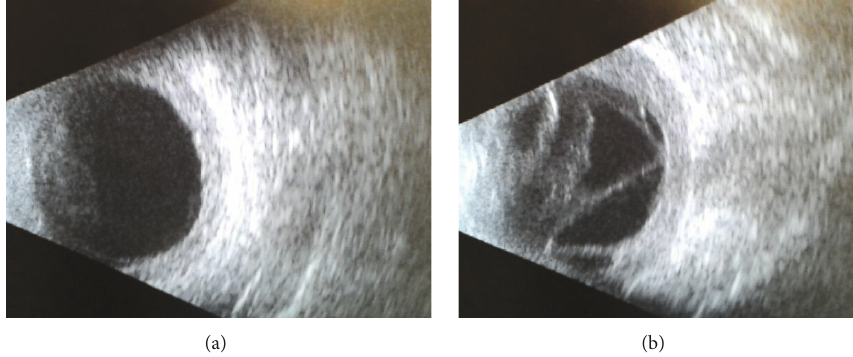
Figure 2: ((a) and (b)) B scan US of right eye and left eye.